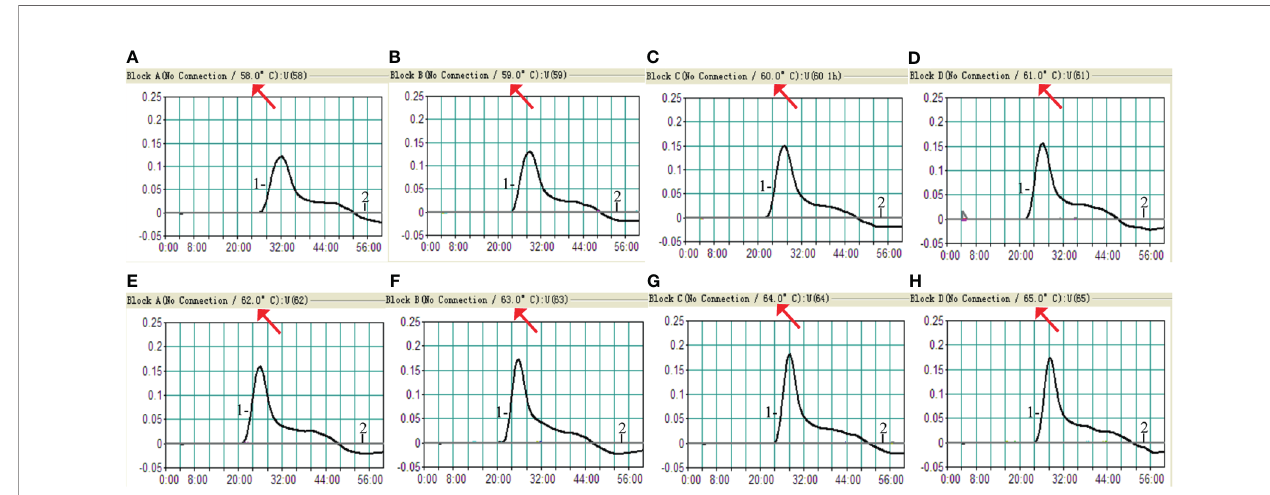
FIGURE 3 | Ampli fi cation temperature optimization for H. in fl uenzae -MCDA assay. The MCDA reaction for detection of H. in fl uenzae was monitored by real-time turbidimeter, and the corresponding curves of concentrations of DNA were showed in the pictures. The threshold value was 0.1, and the turbidity of > 0.1 was considered positive. Eight kinetic graphs (A – H) were acquired at a series of temperatures from 5 to 65°C (with 1°C intervals) with DNA templates of H. in fl uenzae at the level of 1 pg per reaction. Signal 1, positive ampli fi cation of H. in fl uenzae strain; signal 2, negative control of Staphylococcus aureus